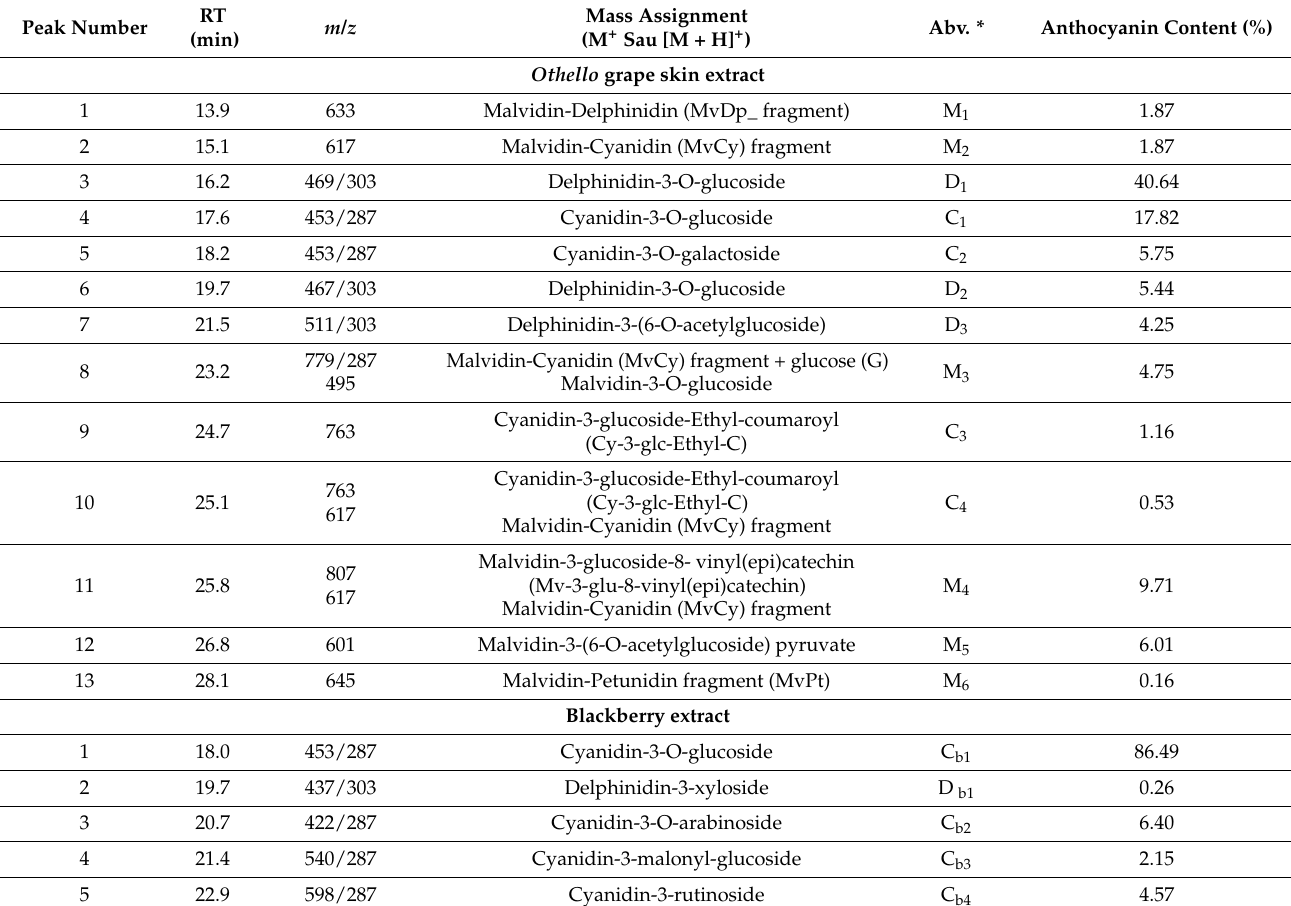
Figure 5. The total ESI/MS positive—ion mode analysis and HPLC profile of blackberry extract. The red number represents the peak number so that it can be identified in Table 2. Table 2. Peak assignment, retention time, mass special data, and percentage of grape skin and blackberry anthocyanins detected by HPLC and Electrospray